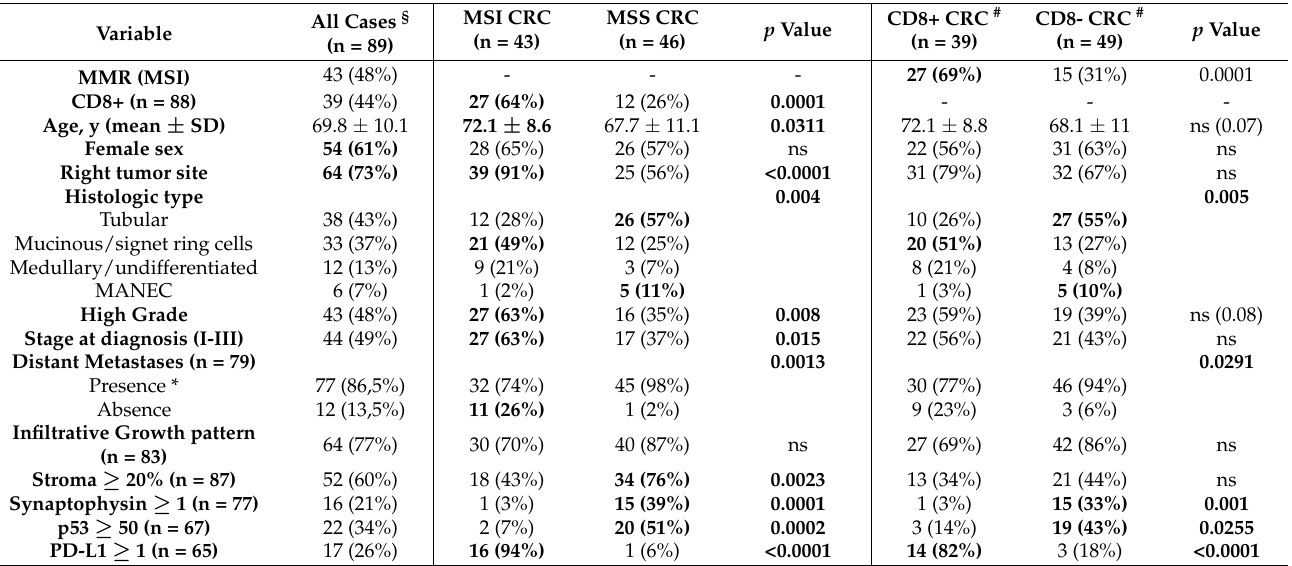
Table 1. Clinico-pathological characteristics of BRAF-CRCs based on MMR status and on CD8+ TIL